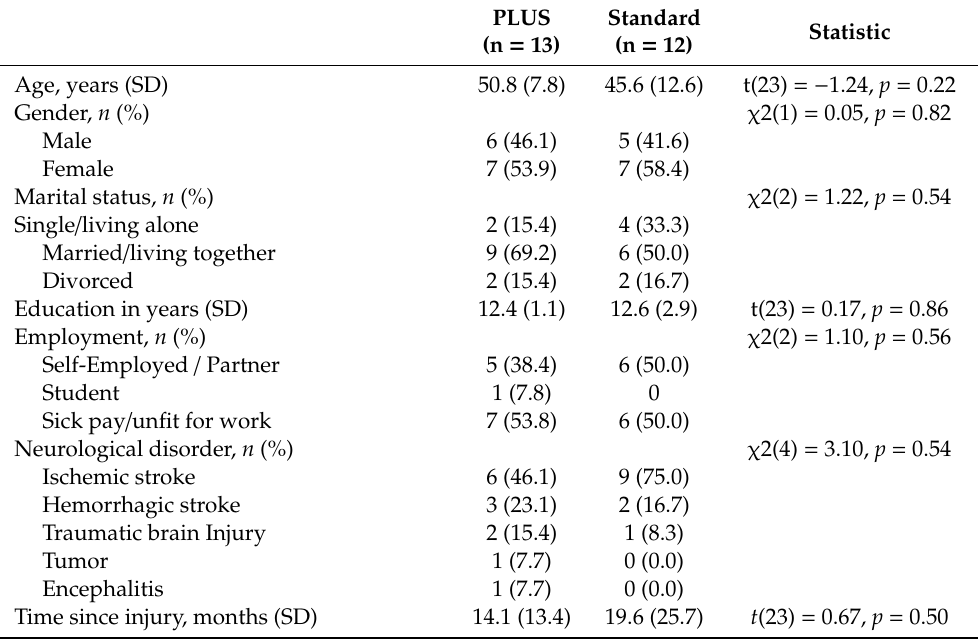
Table 2. Sample characteristics for the Standard PLUS and Standard